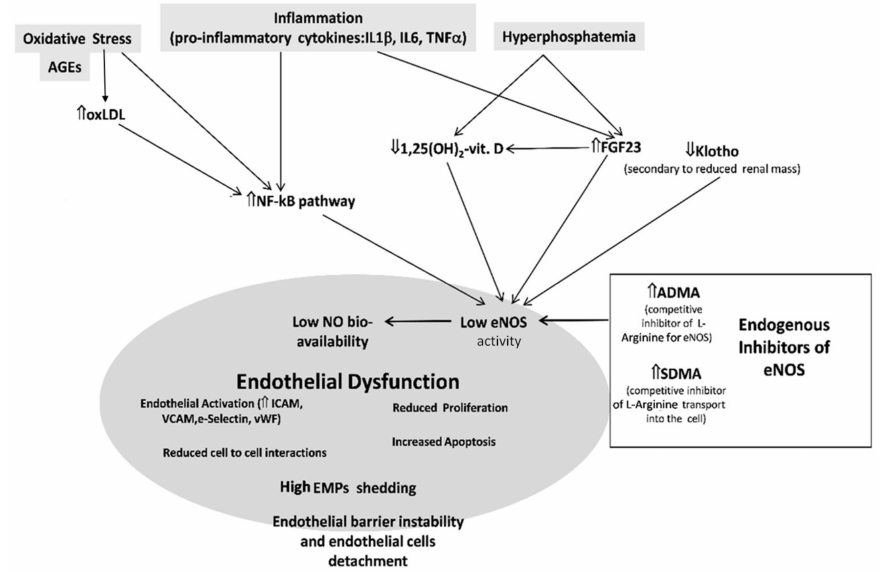
Figure 2. E ff ect of chronic kidney disease (CKD)-related factors on the vascular endothelium. Oxidative stress and advanced glycation end-products (AGEs), inflammation, low vitamin D, high phosphate and fibroblast growth factor 23 (FGF23), and low Klotho and endogenous inhibitors of eNOS that accumulate in CKD all contribute to reduce NO bioavailability in CKD, thereby triggering endothelial dysfunction (ED). Abbreviations: ADMA, asymmetric dimethylarginine; AGEs, advanced glycation end-products; EMPs, endothelial microparticles; eNOS, endothelial nitric oxide synthase; FGF23, fibroblast growth factor 23; IL- β , interleukin- β ; IL6, interleukin6; ICAM, intercellular adhesion molecule; NF- κ B, nuclear factor kappa-light-chain-enhancer of activated B cell; NO, nitric oxide; Ox-LDL, oxidized low-density lipoprotein; TNF α , tumor necrosis factor alpha; VCAM, vascular adhesion molecule; vWF, von Willebrand factor. ⇑ Increase, ⇓